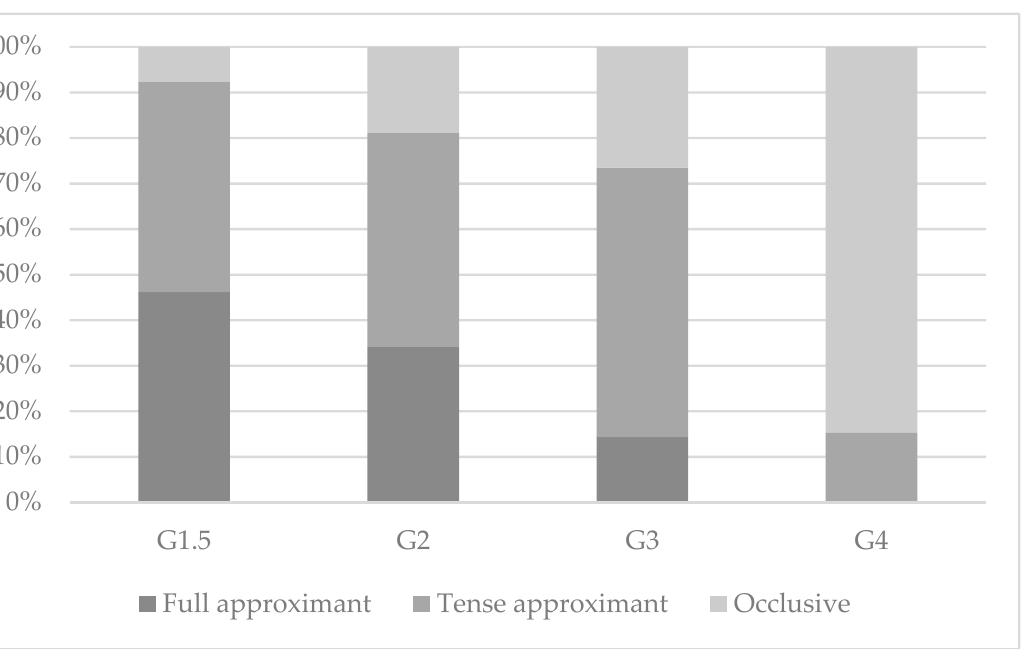
Figure 6 has the rates of production types for the bilabial segment across generations.